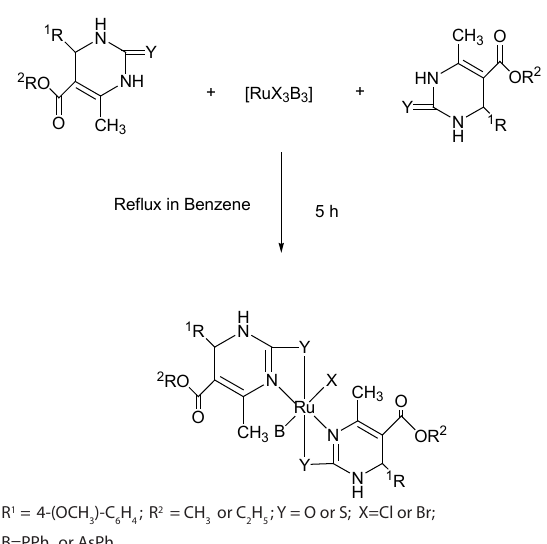
Scheme 1. Preparation of ruthenium(III)